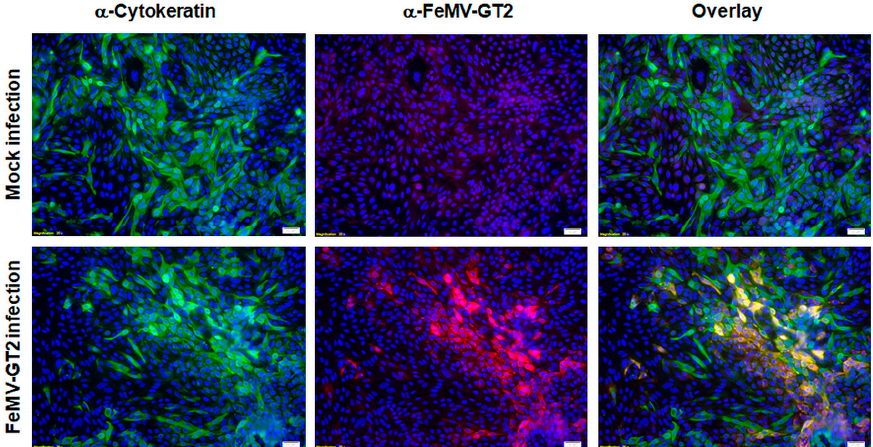
Figure 4. Susceptibility of primary feline kidney cells to FeMV-GT2. Cells were inoculated with FeMV-GT2-Gordon strain (MOI = 0.5) or mock-infected, fixed five days p.i. and stained for cytokeratin (shown in green) or FeMV-GT2 (shown in red). Double positive cells are orange colored. Cell nuclei were visualized with DAPI (shown in blue). Images were taken at 200-fold magnification. Scale bars represent 20 µm.